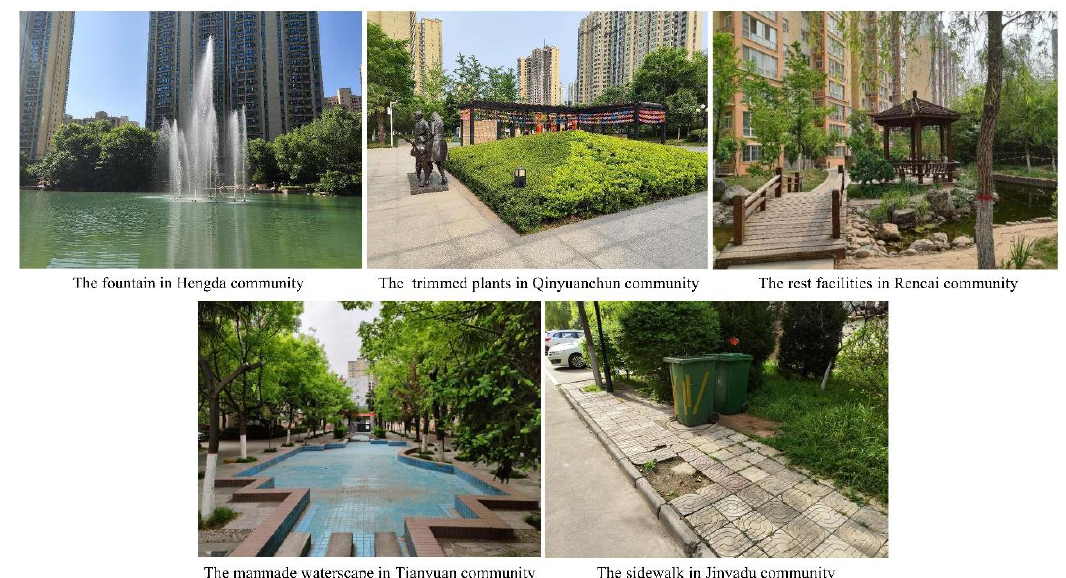
Figure 2. Current stauts of landscape of the five residential communities.